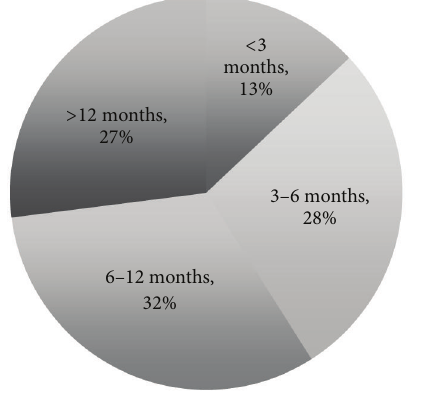
Figure 4: Period of wearing MEW at the time of the survey.